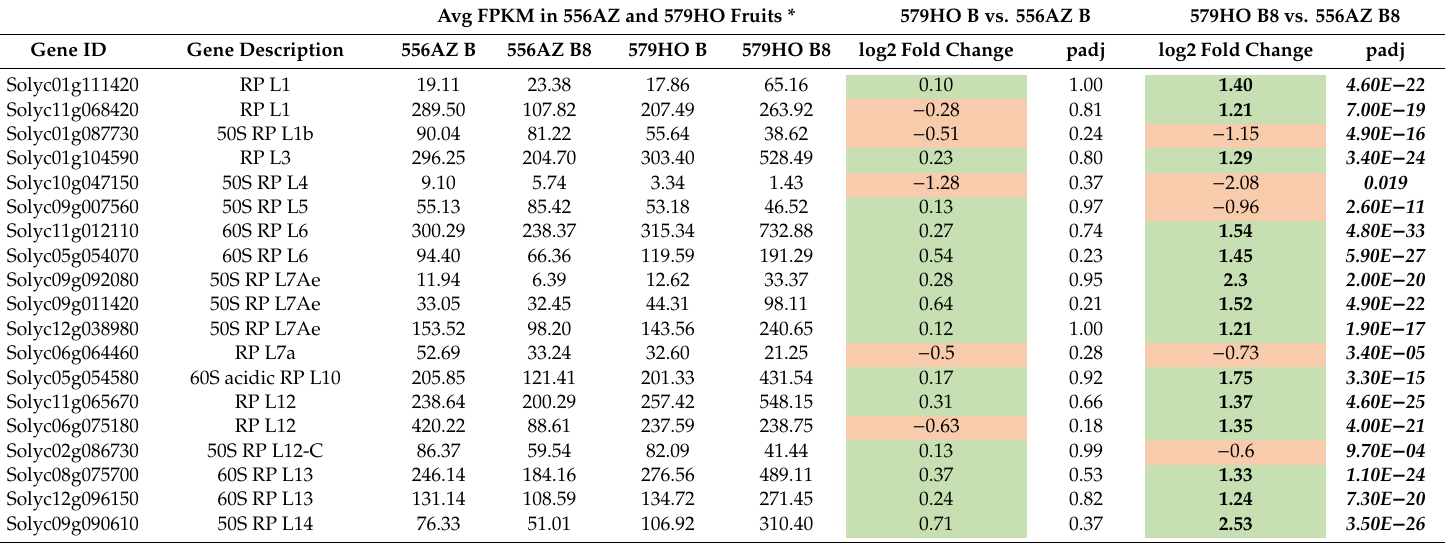
Table 2. Di ff erential expression of ribosomal protein in 556AZ and 579HO tomato fruit at breaker (B) and breaker + 8 (B + 8)